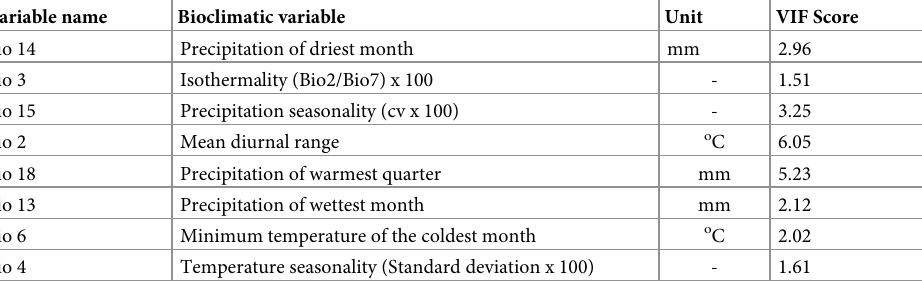
Table 1. Bioclimatic variables used in the final suitability model and their variance inflation factor